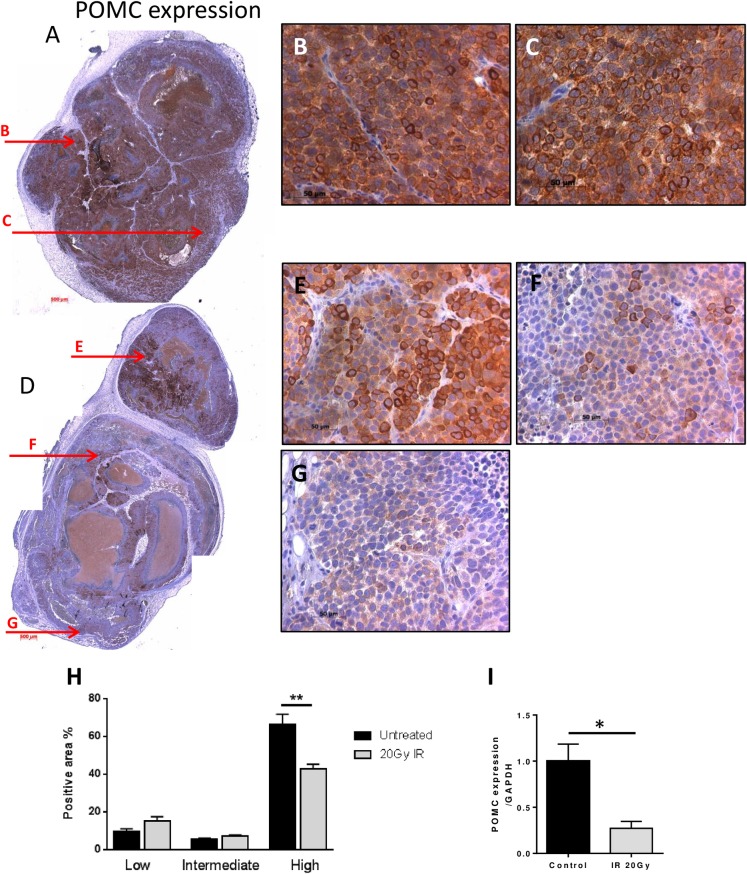
POMC heterogeneity in xenograft tumours after irradiation.DMS 79 cells were established as subcutaneous tumours in nude mice and either left untreated (A-C) or exposed to IR for 10 consecutive days at 2Gy/day (D-G). A central section of the tumour was stained for POMC using our own N1C11 antibody. (A&D) show entire tumour cross-sections, (B&C) show strong homogeneous POMC staining in separate tumour areas in untreated DMS 79 xenografts. (E-G) show viable tumour cell regions of an irradiated DMS 79 xenograft revealing (E) strong staining, (F) weaker heterogeneous staining, (G) weak staining. (H) Quantitive assessment by positive pixel analysis of untreated tumours and 20Gy IR treated tumours stained for POMC. (I) POMC gene expression was analysed in all untreated and 20Gy IR tumours. Tumours presented are representative of 3–5/group with all other tumours in S2 Fig.